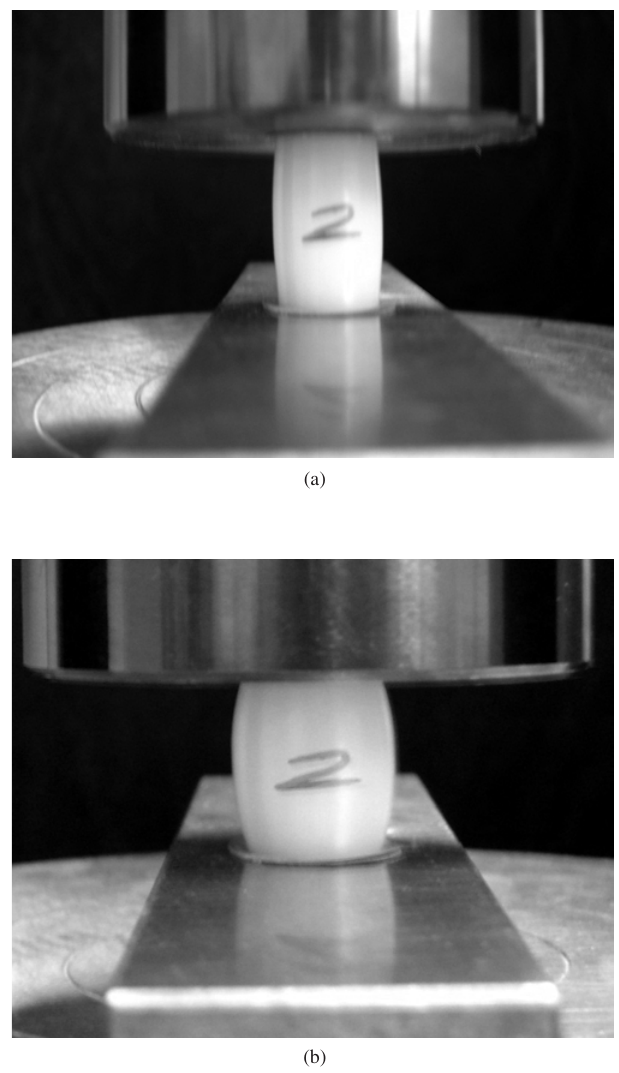
Figure 4. Specimen behavior with sandpaper between platens and specimen: a) at the test beginning; and b) at test